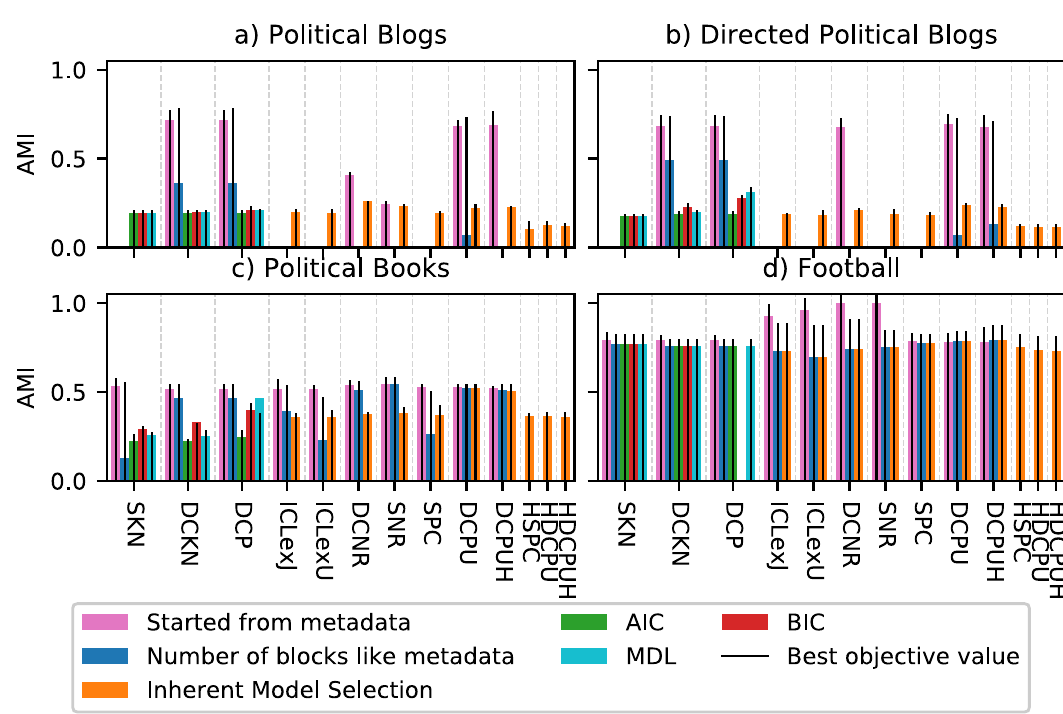
Fig 18. Results of inference of real networks. Each model beside the hierarchical ones (HSPC, HSDCPU, HDCPUH) was executed 10 times with MHA with 250 000 steps from the partition given by the metadata and for each group size between 1 and 15 (respectively 25 for the football network) from 10 random starting points. For these models the figure includes results of the start from the metadata and for partitions with the same number of groups like the metadata. The classical SBM also contain the results for the three presented model selection AIC, BIC and MDL. Whereas, the models, which include the model selection step, show instead the results of their model selection. The hierarchical SBM variants only show the results of 10 executions with algorithm for the hierarchical models. The bars represent the average of the 10 independent runs (for the one with model selection one execution per group size) and the solid line in the middle of each bar represents the AMI of the partition with the best objective value. Bars not visible relate to results near to zero and the dashed gray line with its white space was added to separate the models.